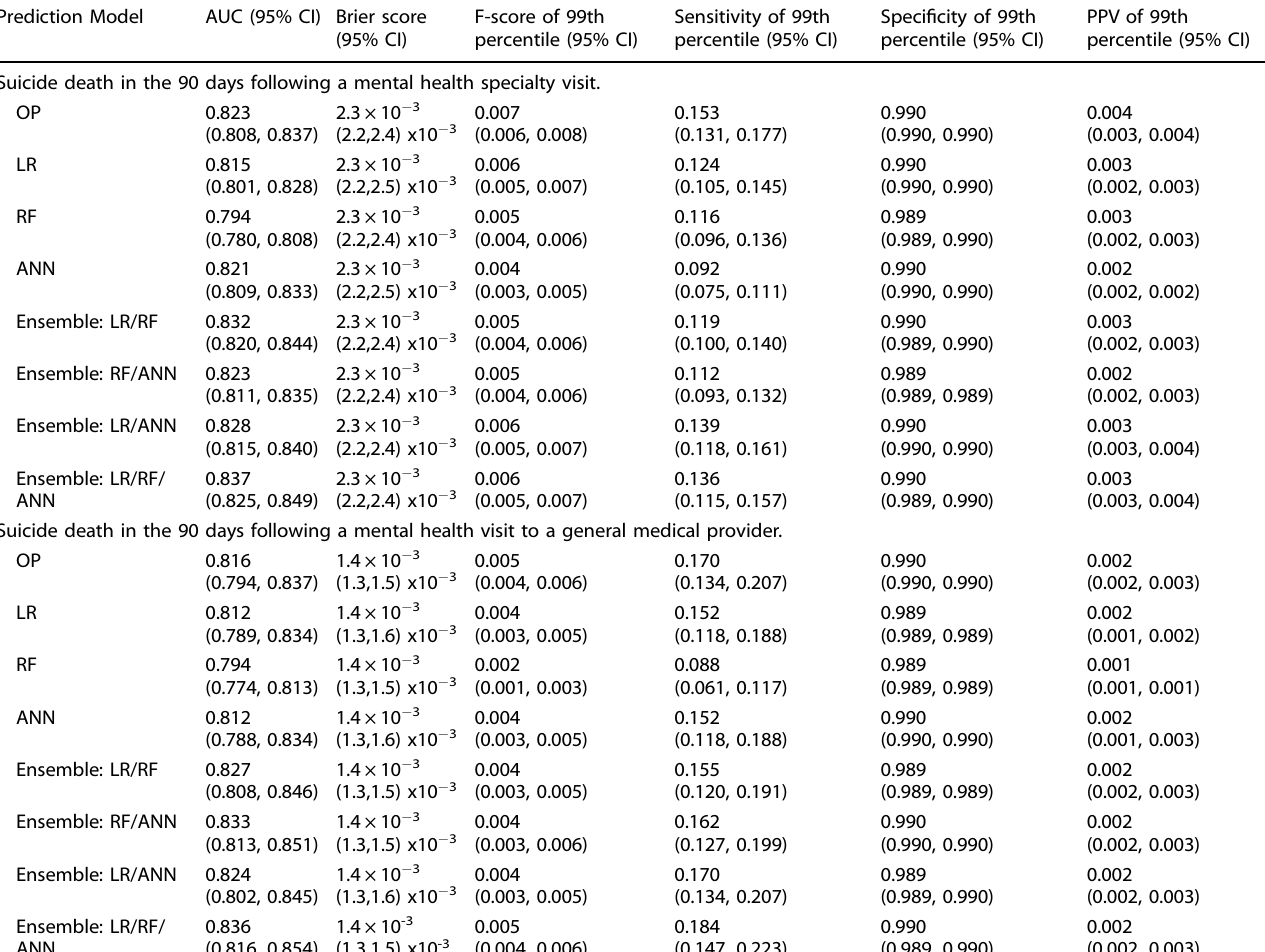
Table 6. Prediction performance in entire validation data for suicide death in the 90 days following an outpatient visit; 95% con fi dence intervals (CIs) constructed using 10,000 bootstrap